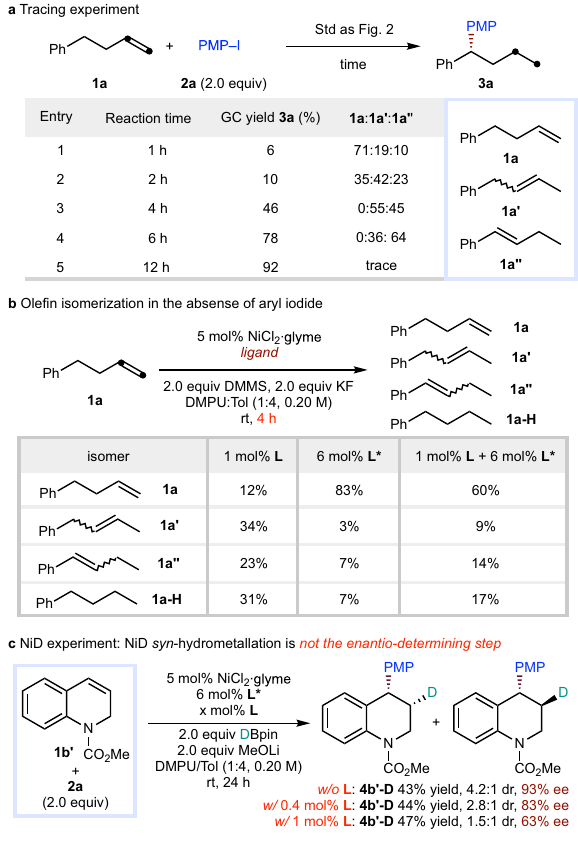
*Yields determined by GC using n -dodecane as the internal standard, the yield in parentheses is the isolated yield.